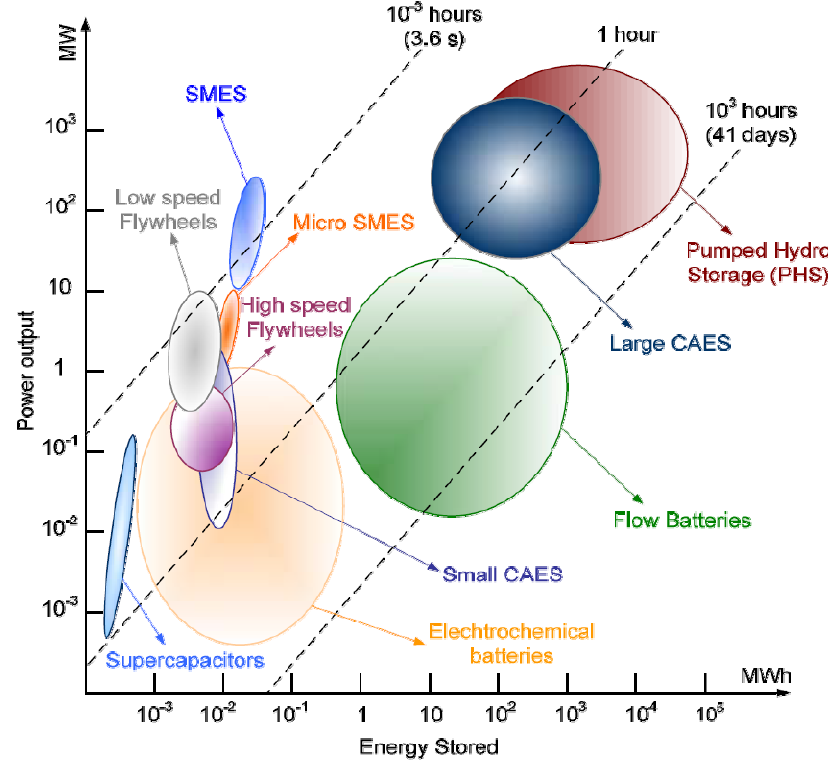
Figure 1. Energy storage systems with different storage capacity [9].